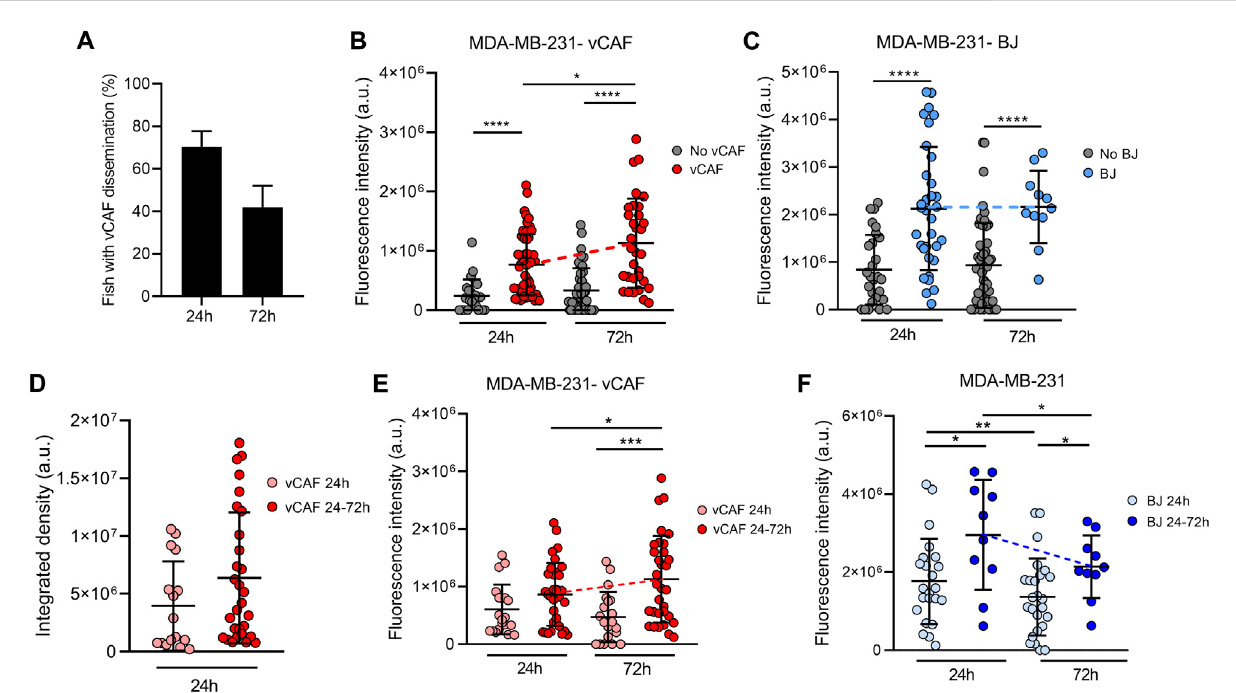
FIGURE 4 Evaluation of the survival of CTCs and CAFs in the zebra fi sh embryo xenografted with het CTC-C. (A) Percentage of fi sh xenografted with MDA-MB- 231andvCAF het CTC-Cshowingdisseminated fi broblastsinthetailat24and72 hpi;Dotplotsofthe fl uorescenceintensityofMDA-MB-231disseminated in the fi sh tails according to the presence or absence of vCAF (B) and BJ (C) fi broblasts; (D) Dot plot of the integrated fl uorescence density of vCAF disseminated in the fi sh tails; Dot plots of the fl uorescence intensity of MDA-MB-231 disseminated in the fi sh tails according to the survival of vCAF (E) andBJ (F) fi broblaststhroughouttheexperiments.Eachdotrepresentsanindividual fi sh( n =3independentexperiments).* p < 0.05,** p < 0.01,*** p < 0.001, **** p <